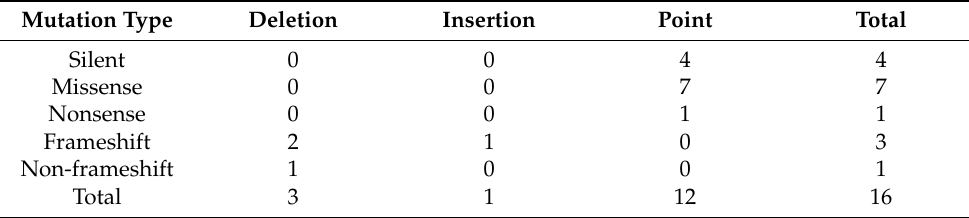
Table 3. Summary of the mutational spectrum observed in